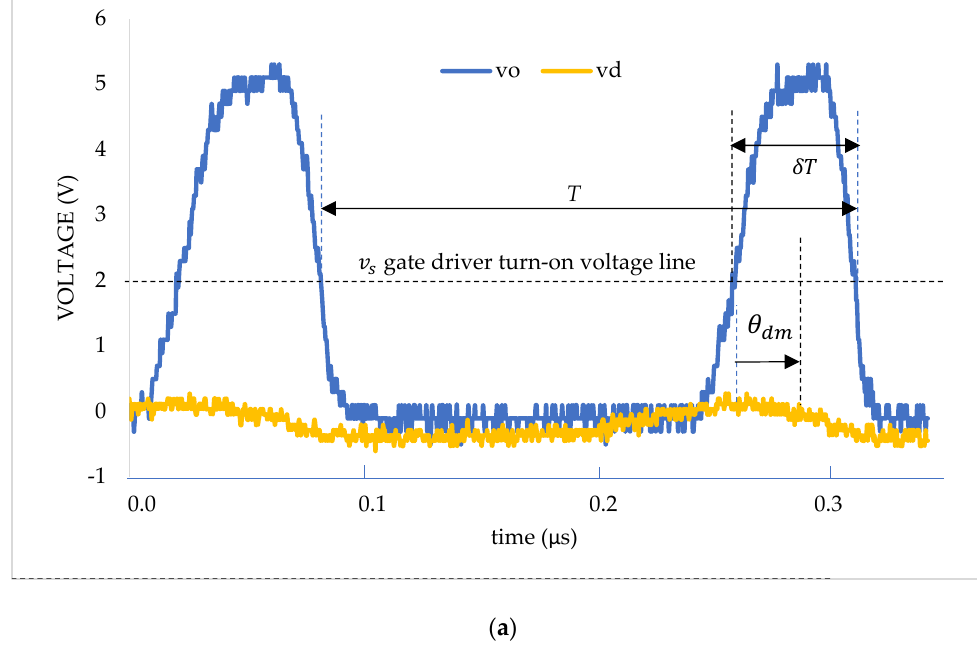
Figure 17. ( a ) VFPWM output and v d from a low-resistance dCCDA. ( b ) VFPWM output (= v s ) versus the VCO output (= v VCO ) and v d of the VCO in series with the high-resistance